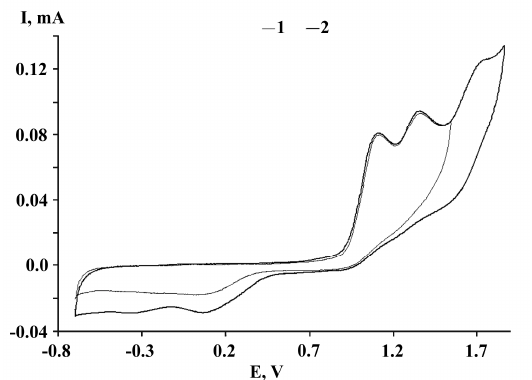
Figure 3. Cyclic voltammograms of compound L 1 (in the potential switch from − 0.70 to 1.5 V—curve 1; in the potential switch from − 0.70 to 1.85 V—curve 2) (MeCN, C = 3 mM, 0.15 M TBAP, scan rate 200 mV · s − 1 ). Molecules 2020 , 25 , 1770